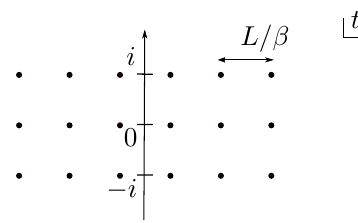
Figure 10 . Sketch of the analytic structure of the modular correlator G mod ( x, y, t ) (4.21) for fixed x, y belonging to a single interval on the torus. The function is analytic everywhere except at simple poles (black dots), located at the solutions to (3.28), which lie on a lattice of spacings i and L/β respectively. In the limit of low temperature β → ∞ , the real component of the spacing between poles vanishes. This behaviour is the origin of the branch cut in the case of the cylinder (P), figure